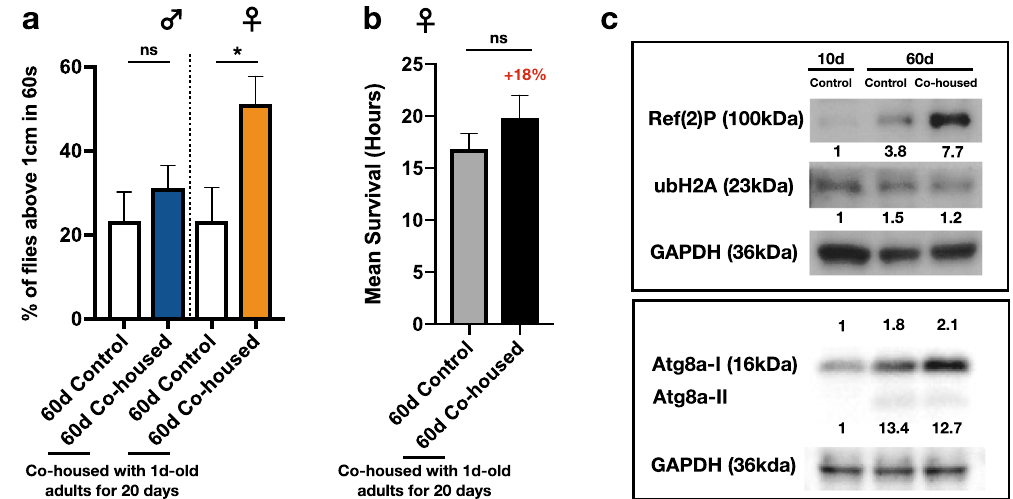
Fig. 4 Aged fl ies receiving the youth impacts maintain better physiological fi tness. a Motor activity (negative geotaxis) was assayed in the 60d-old control Canton-S fl ies (indicated as 60d Control) and 60d-old aged fl ies that have been co-housed with 1d-old young Canton-S fl ies for 20 days (indicated as 60d Co-housed). Each condition included 6 independent replicates and a total of 30 fl ies. Results were expressed as mean percentages ± SEM. b 60d-old control Canton-S fl ies (indicated as 60d Control) and 60d-old aged fl ies that have been co-housed with 1d-old young Canton-S fl ies for 20 days (indicated as 60d Co-housed) were subjected to desiccation. The mean survival time ± SEM of each condition was calculated and illustrated as the bar graph. P values: ns > 0.1234; <0.0332*. P values of the columns were annotated by the Mann – Whitney test. Each condition included 10 fl ies. c Protein levels of Ref. 2 P, Atg8a-I/Atg8a-II, ubH2A, and GAPDH in the whole animal lysates derived from fl ies of the indicated condition were examined by the Western blot analyses. Label of each lane was: (1) 10d, Control: 10d- old young Canton-S fl ies. (2) 60d, Control: 60d-old aged Canton-S fl ies, (3) 60d, Co-housed: 60-old aged Canton-S fl ies that have been co-housed with 1d-old young fl ies for 20 days. Levels of GAPDH were used to normalize total protein input. Each lane contained whole animal lysates from 5 fl ies. Results from 2 independent experiments (except the case of Atg8a, triplicates were included) were used to quantitate the differences of protein expression (via the ImageJ program). Fold changes of expression level were compared to the value of 10d, Control (the very left lane; assigned as 1) and indicated at the bottom of Western blot. All Western blots derived from the same experiment were processed in